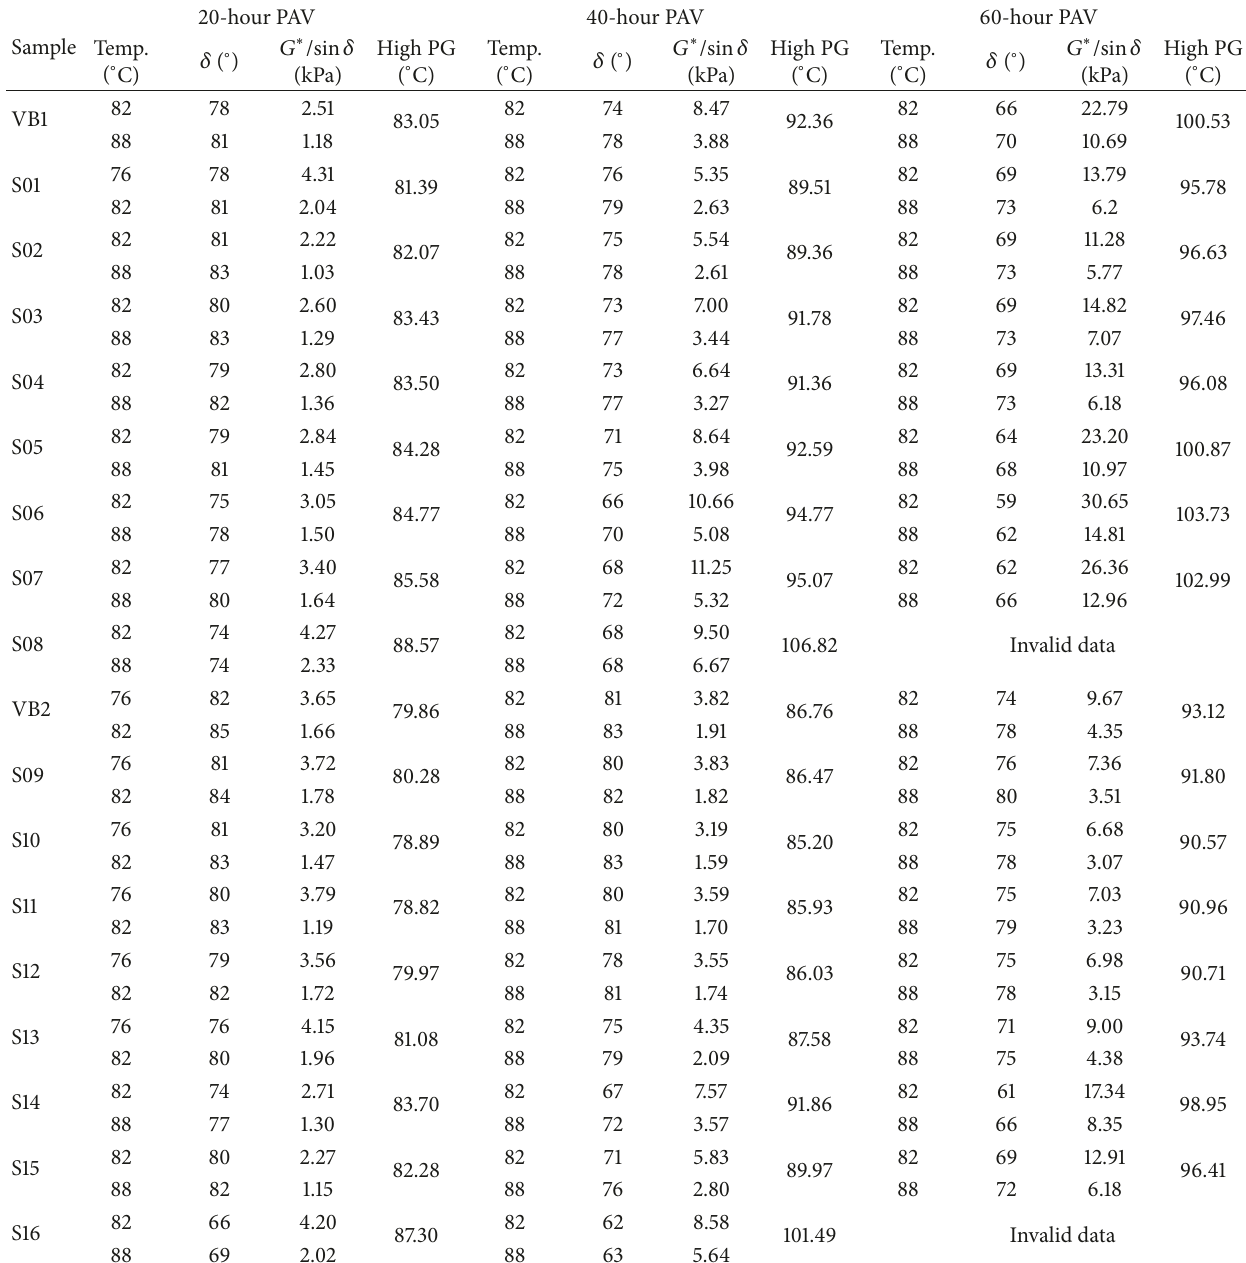
Table 4: DSR tests results for PAV-aged